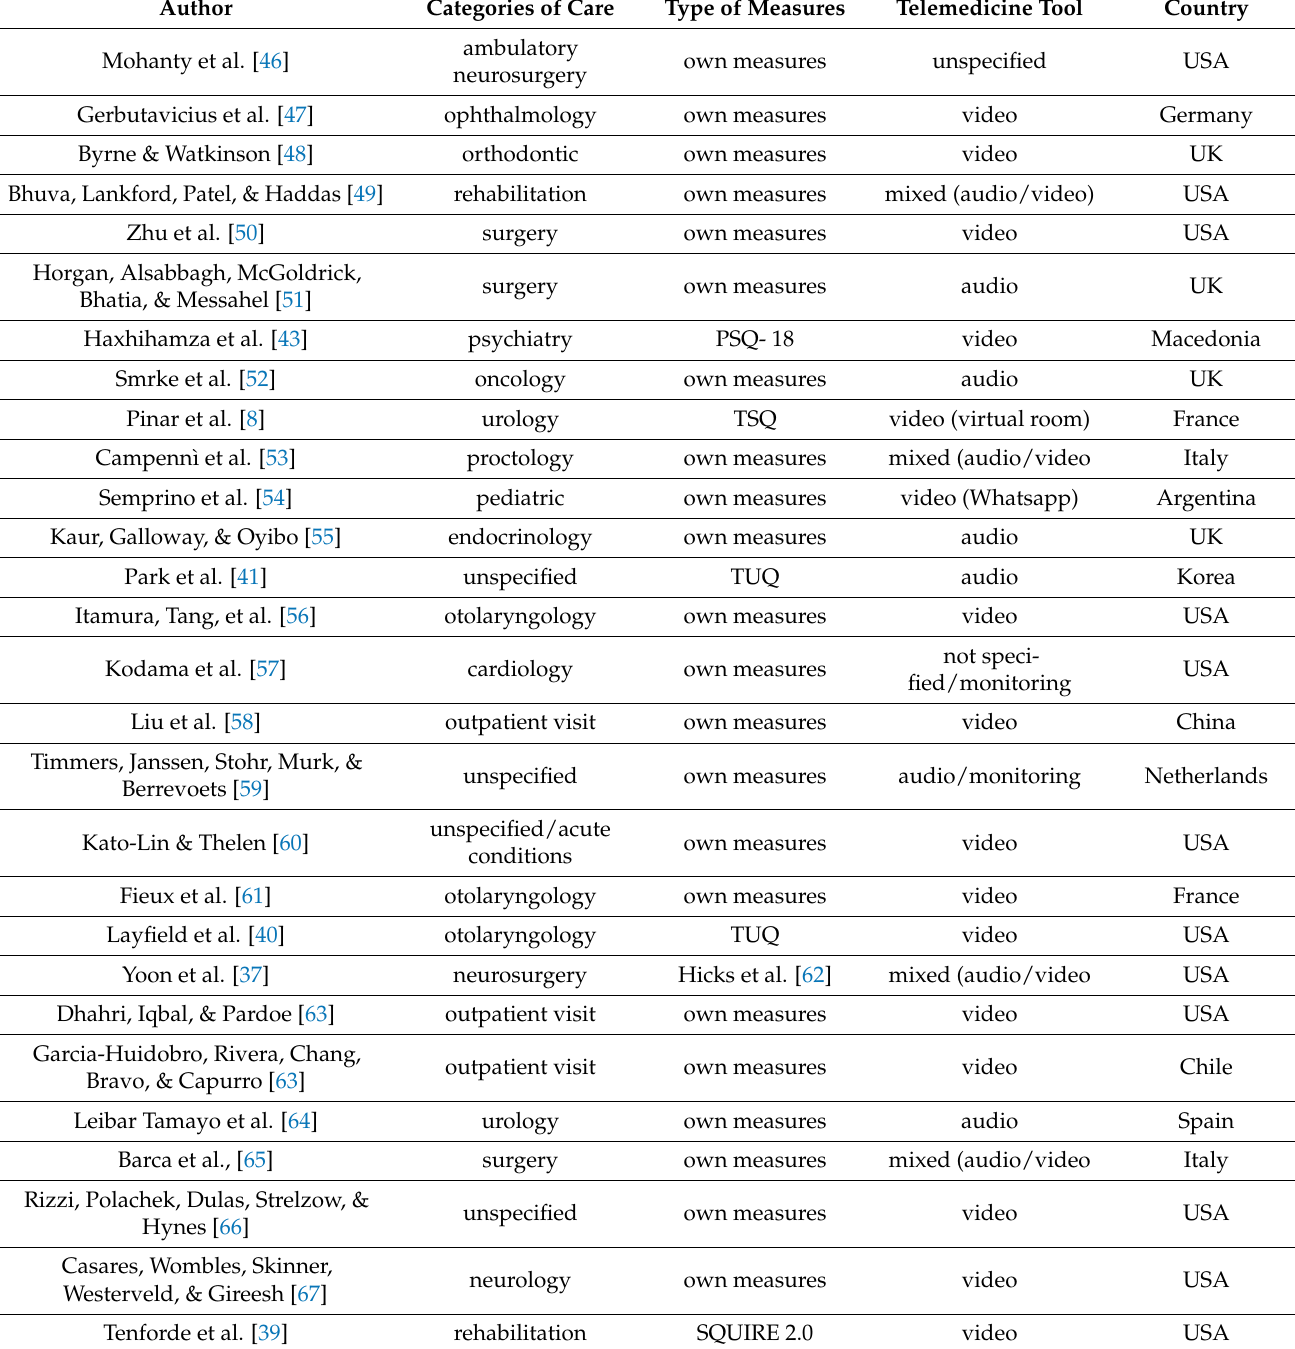
Table 2. Selected characteristics of the research on patient satisfaction during the Covid-19